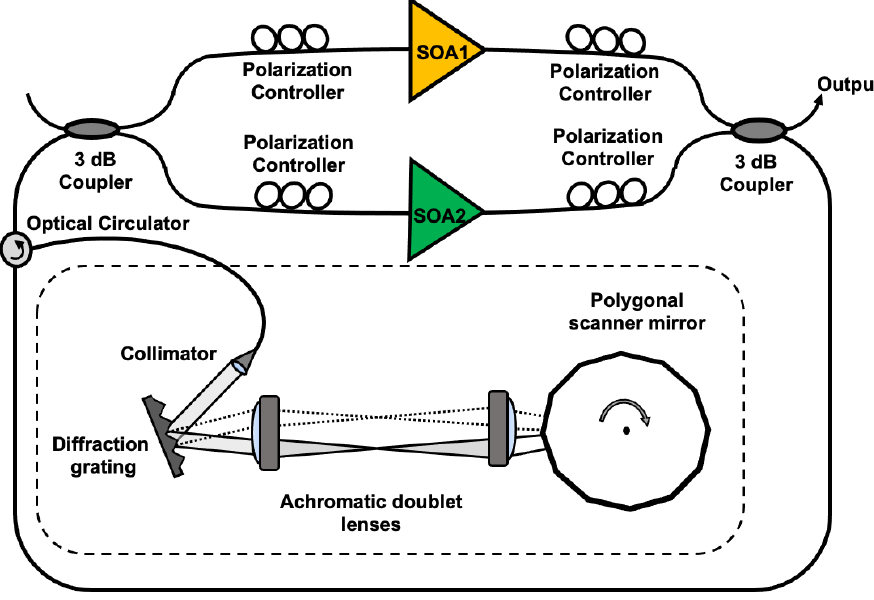
Figure 1. Schematic diagram of an experimental setup, in which two SOAs were connected in parallel in the form of a Mach-Zehnder interferometer.